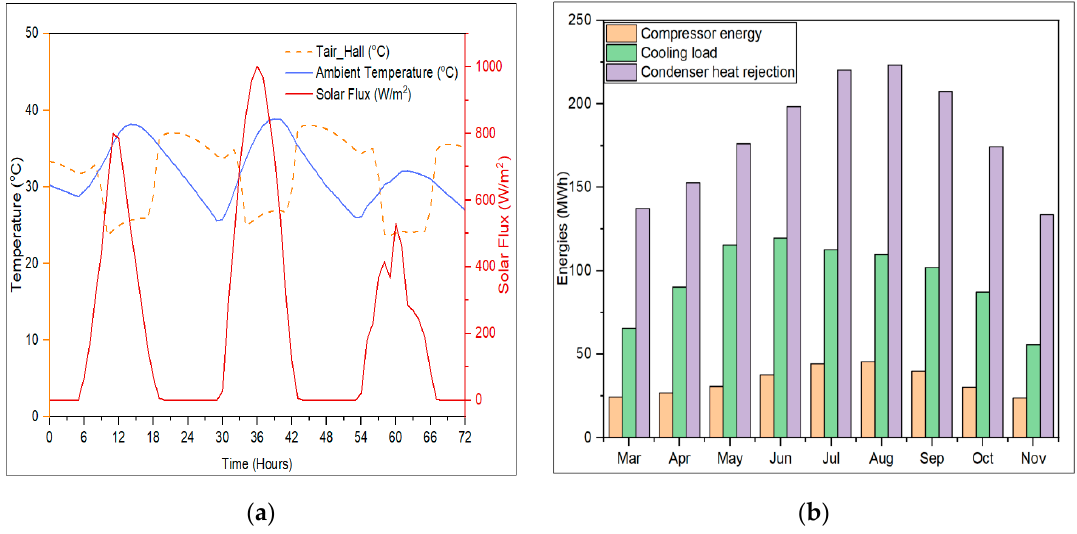
Figure 9. ( a ) Simulation results of water-cooled vapour compression cycle (VCC) chiller for three days (3rd to 5th June of the typical metrological year). ( b ) Water-cooled VCC chiller monthly results.